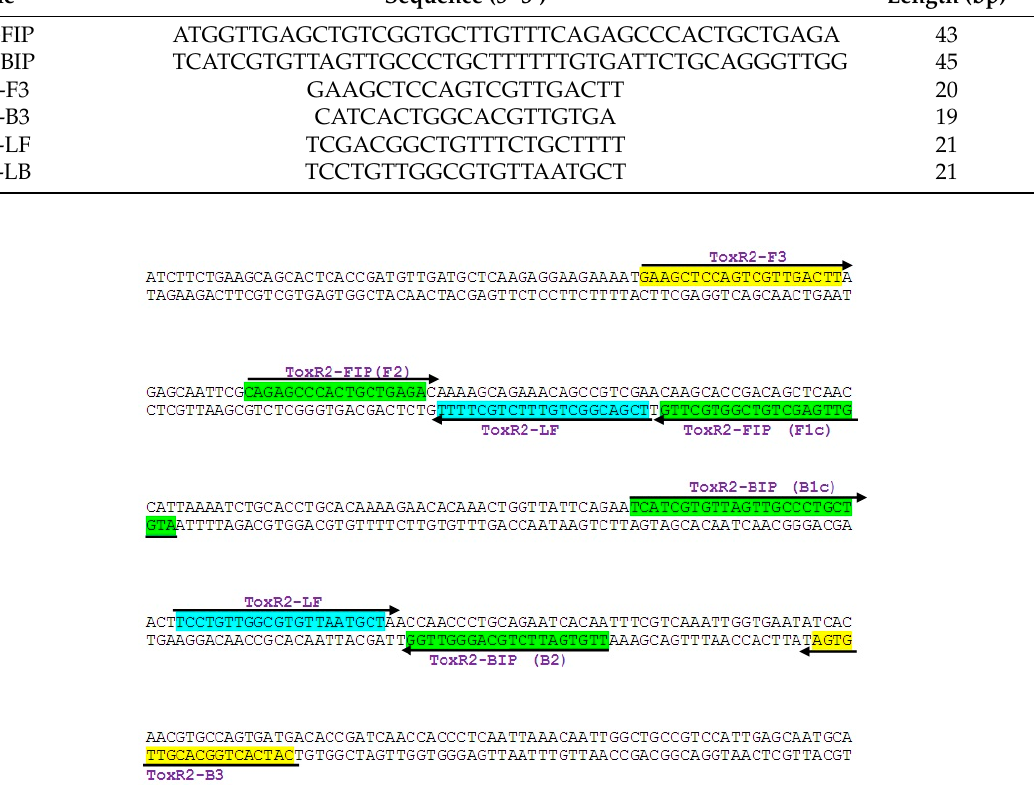
Figure 1. The flanking regions of the inner (green), outer (yellow) and loop (blue) primers based on the toxR gene of V. harveyi for LAMP reaction .